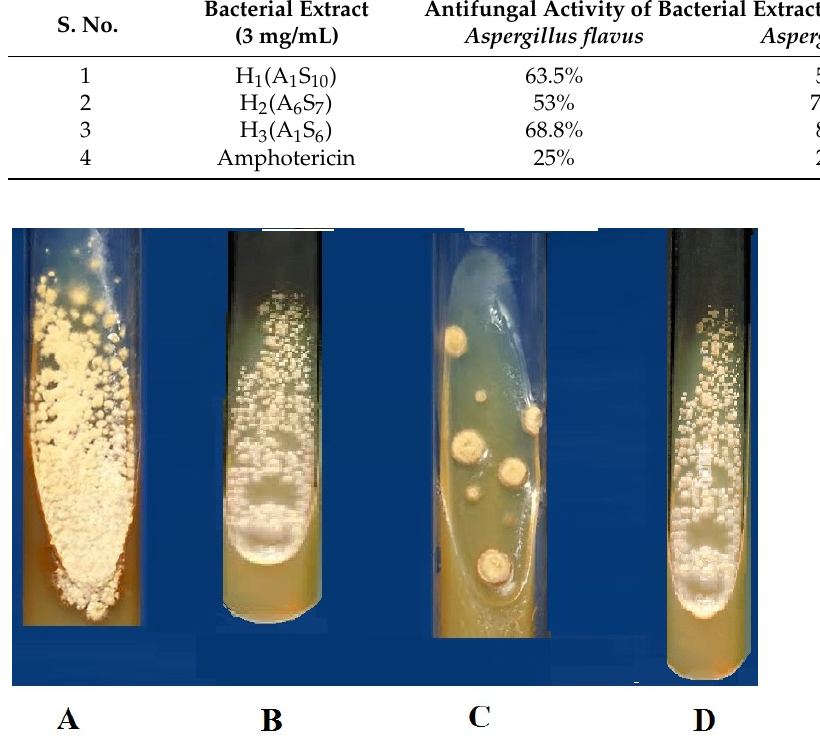
Figure 3. Test tube test for the evaluation of the antifungal activity of metabolites and control (3 mg/mg concentration); ( A ) Control (Amphotericin), ( B ) A 1 S 10 highest inhibition against Aspergillus flavus, ( C ) A 6 S 7 the highest inhibition against Aspergillus niger , ( D ) A 1 S 6 highest inhibition against Aspergillus niger.